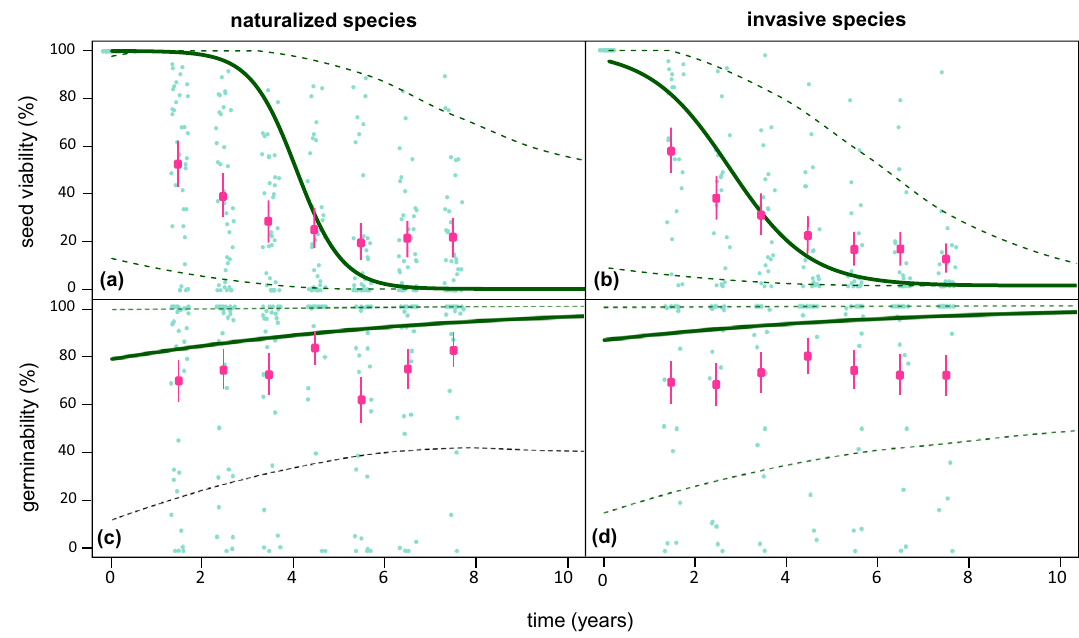
Figure 1. Observed mean seed viability and germinability (percentage) for ( a , c ) 38 naturalized and ( b , d ) 21 invasive species in each year of exhumation (small green dots) over 7.5 years from seed burial (time zero). Square pink symbols indicate observed mean seed viability values (± SE) for all species, within each group of species (naturalized vs. invasive). Overlapped are fitted values and credible intervals resulting from phylogenetically informed logistic models, modelling the decline in seed viability over 10